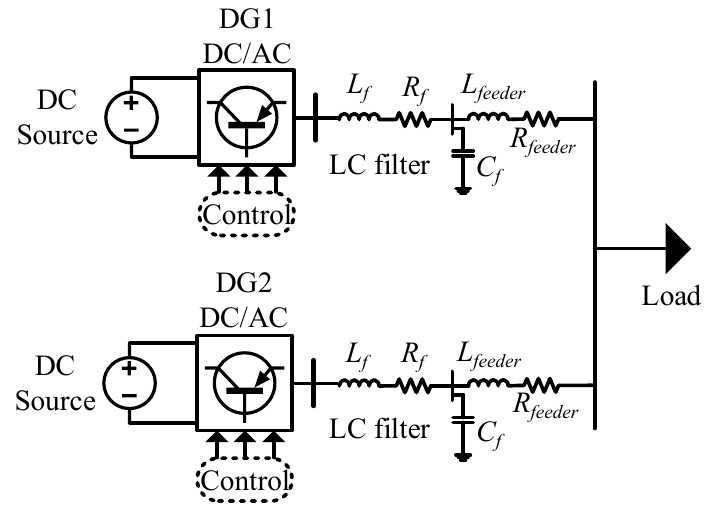
Figure 3. Single line diagram of the test case